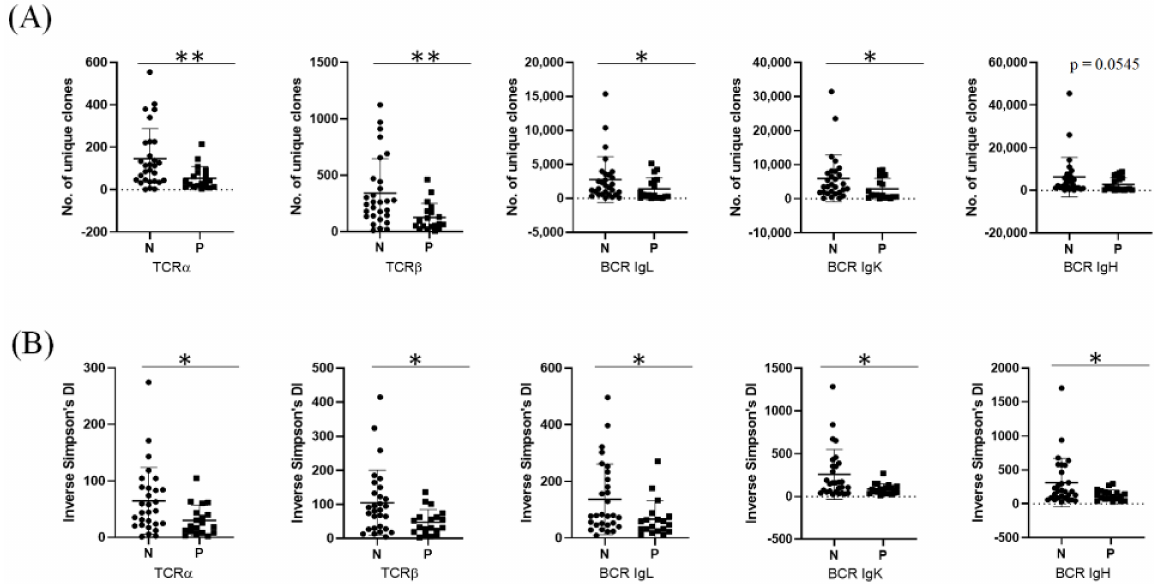
Figure 6. Comparison of the immune receptor repertoires between presented and unpresented subjects. ( A ) Number of unique clone and ( B ) clonal diversity. * p < 0.05, ** p <